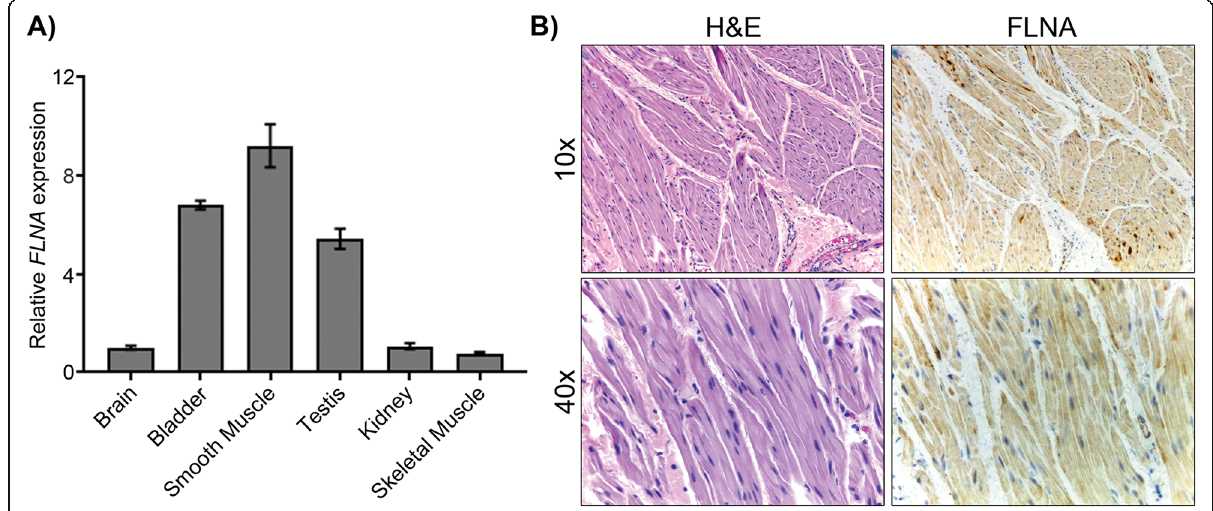
Fig. 3 FLNA is expressed in human bladder smooth muscle. a qPCR across adult human tissues. FLNA expression normalized to GAPDH and relative to brain. b IHC from pediatric normal human bladder shows cytoplasmic and some nuclear smooth muscle expression of